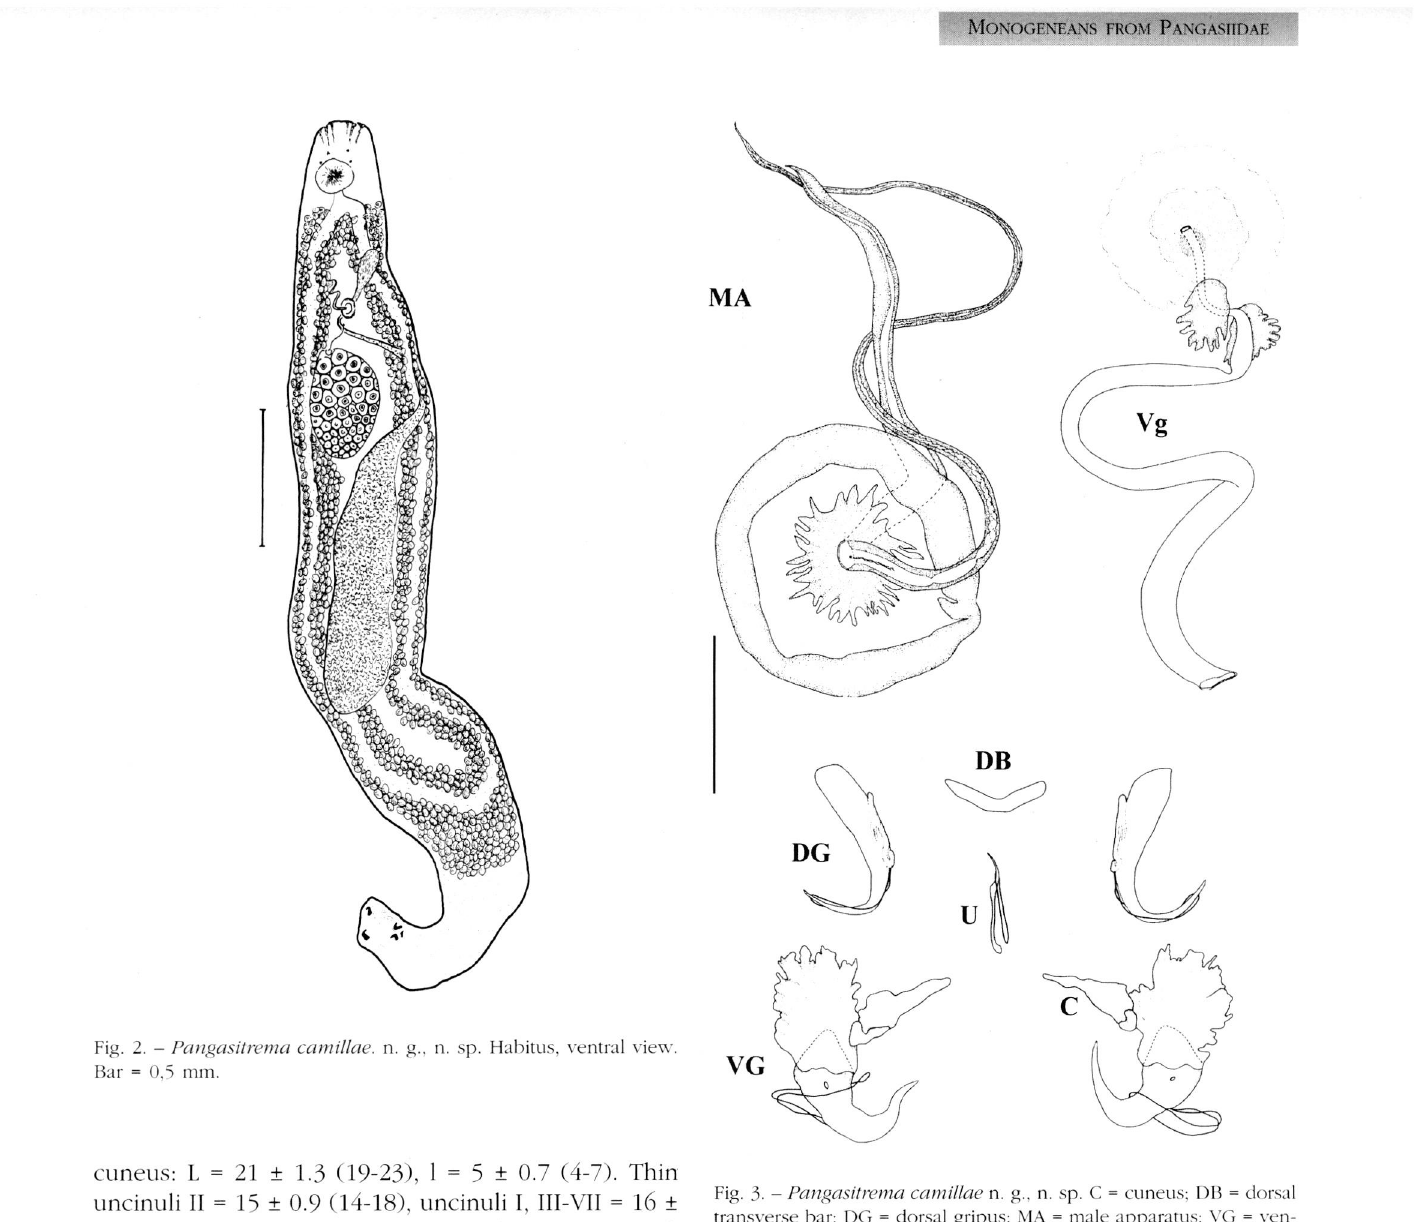
C = cuneus: DB = dorsal transverse bar; DG = dorsal gripus; MA = male apparatus: VG = Neu tral gripus; Vg - vagina; U - uncinuli. Bar = 30